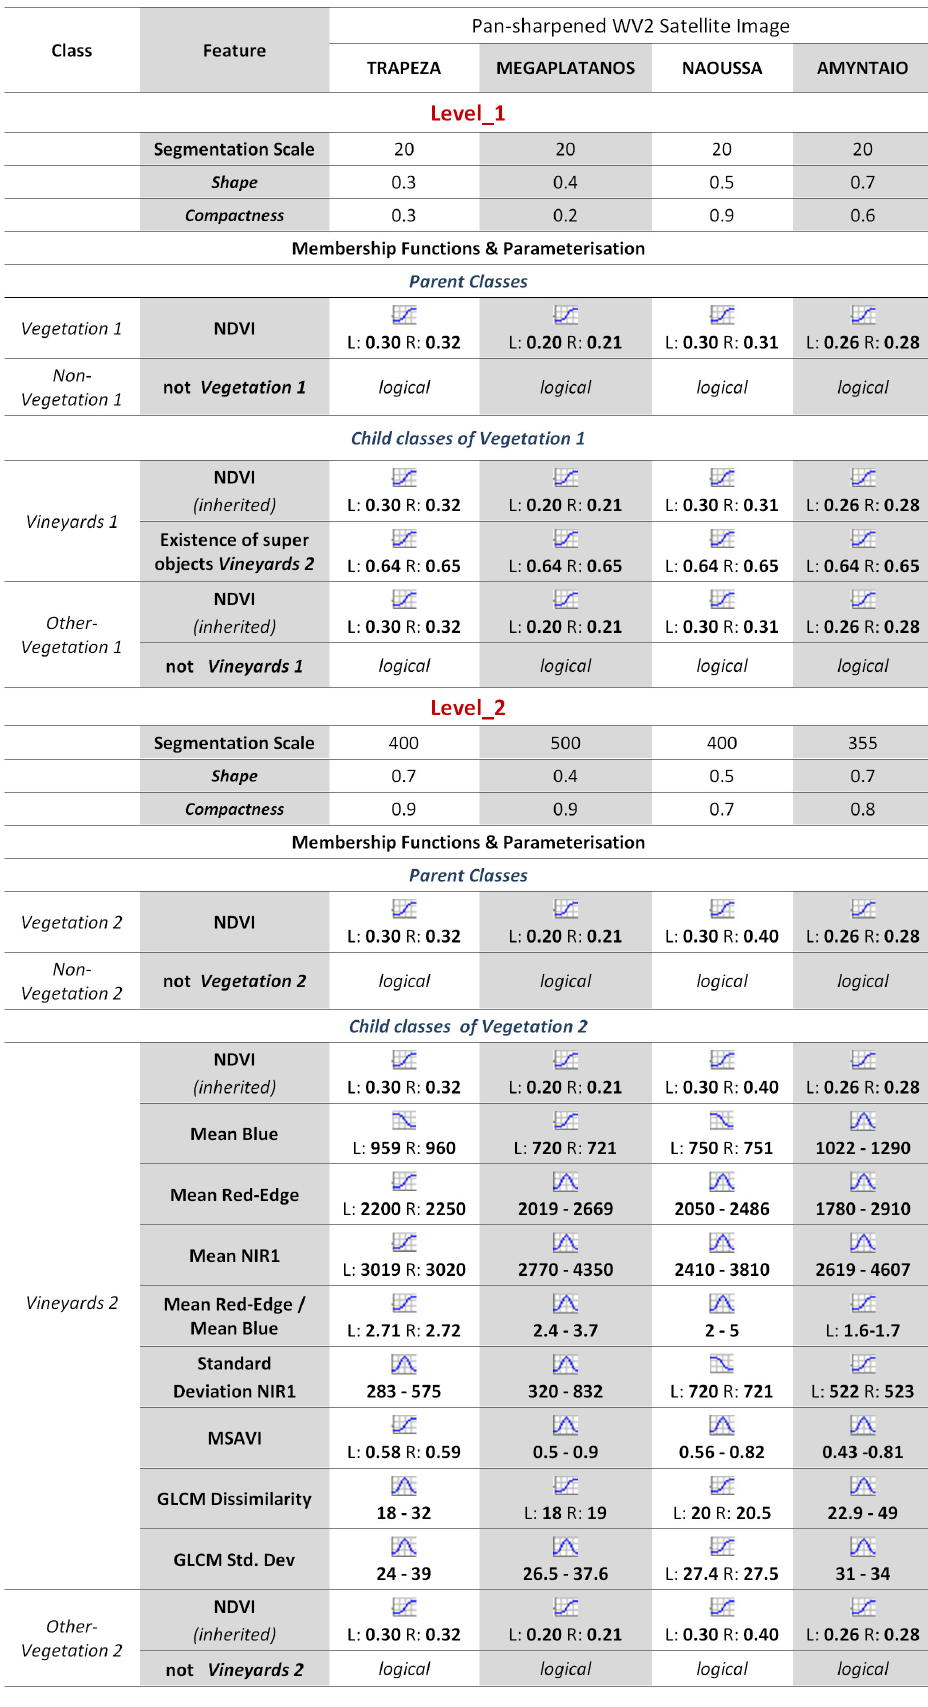
Figure 2. The classification features and rules of the developed vineyard detection